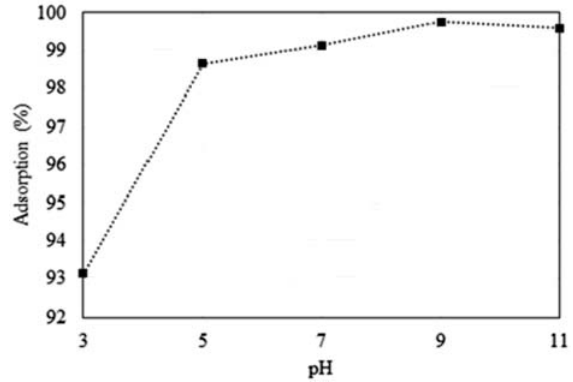
Fig. 2: Adsorption of Cr(III) produced by various pH values